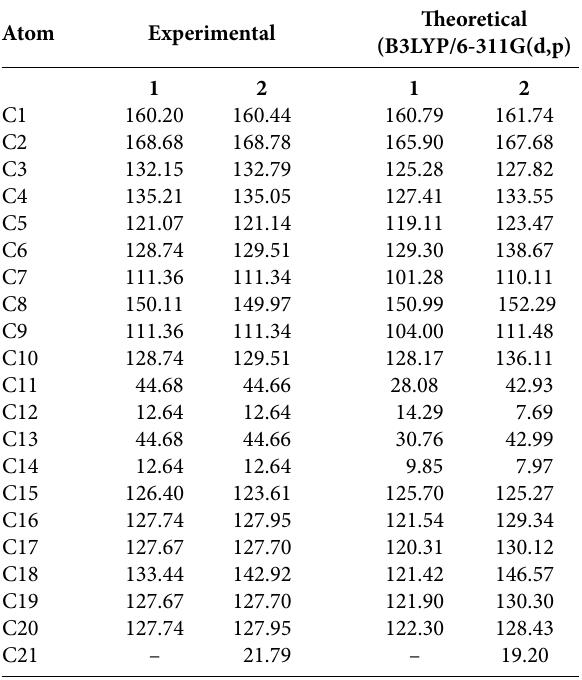
Table 6 . Comparison of the experimental and calculated 13 C NMR values in chloroform. Atom Experimental